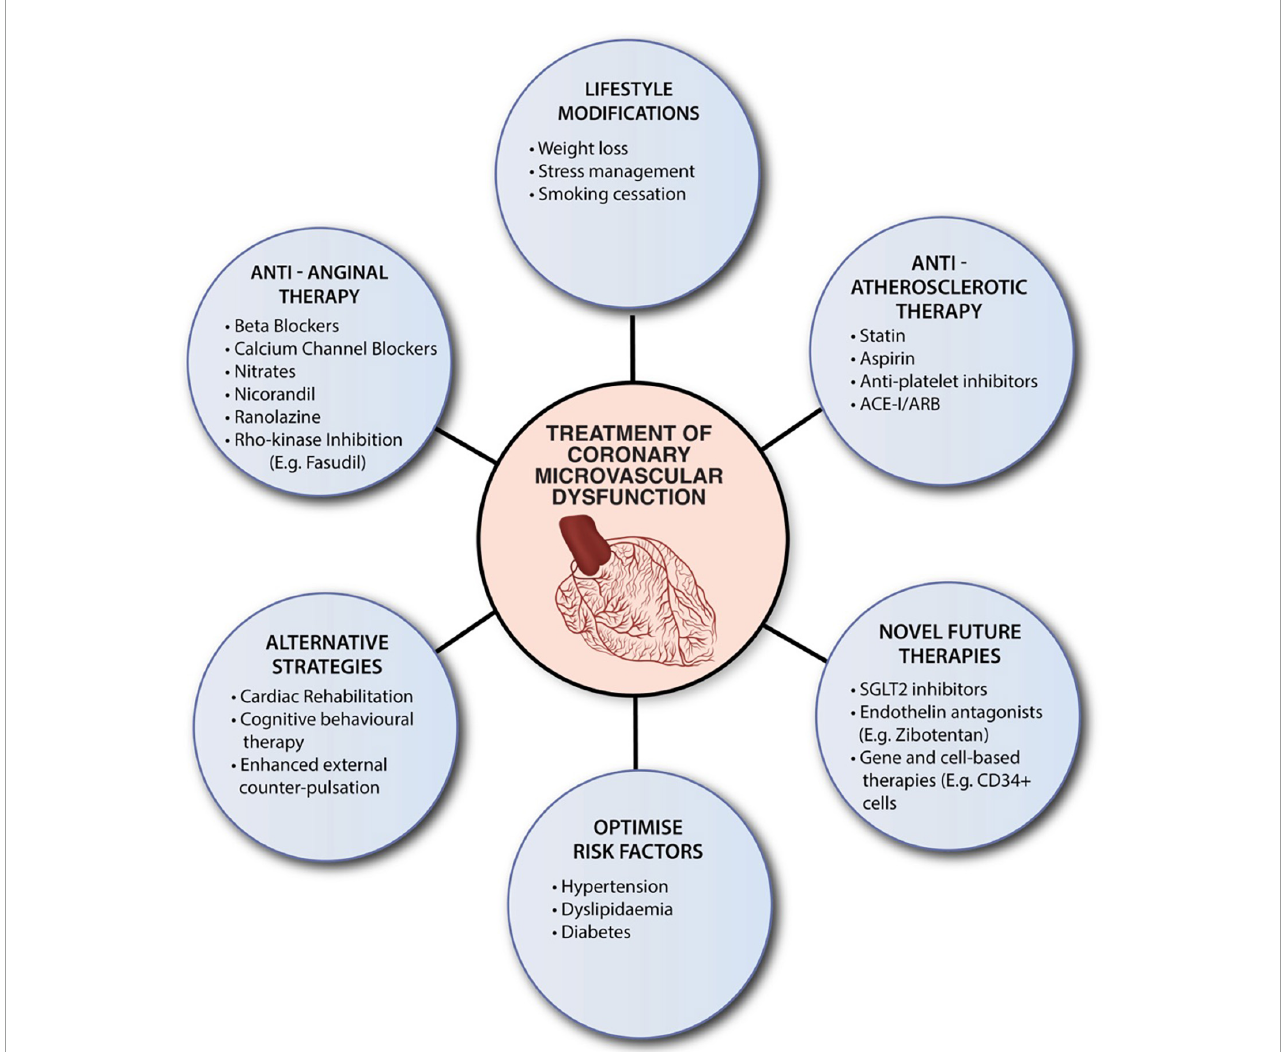
FIGURE2 Summaries current therapeutic strategies for CMD. Despite the absence of specific evidenced-based therapies, clinicians should consider optimizing risk factors, encourage lifestyle modifications, and utilize conventional pharmacological therapy. ACE-1, angiotensin-converting enzyme inhibitors (ACE-I); ARB, angiotensin receptor blockers; SGLT2, sodium-glucose cotransporter-2